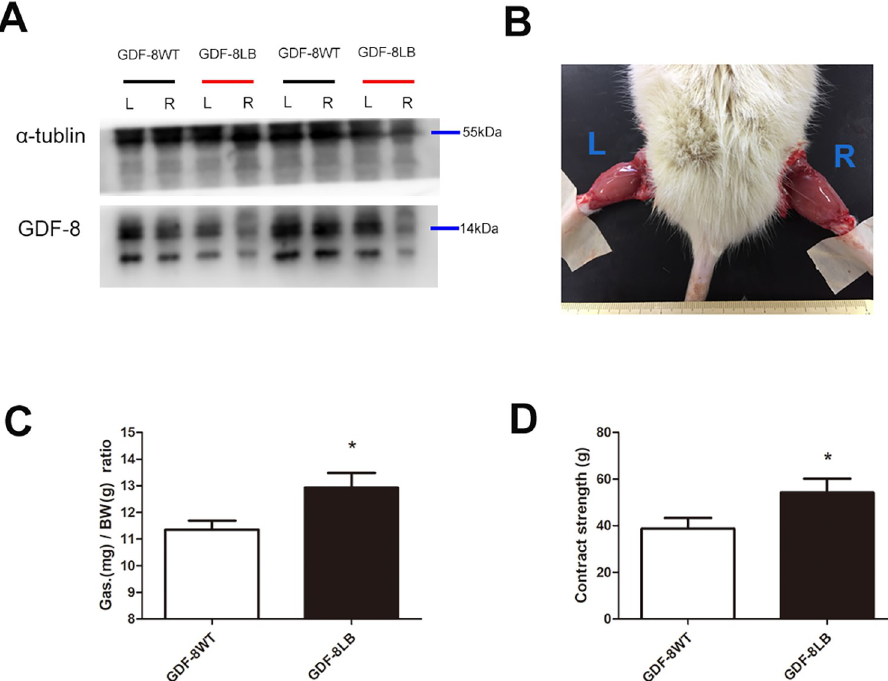
Fig 3. Local blockage of myostatin resulted in increased muscle mass and enhanced muscle strength in the right gastrocnemius muscles. A. expression level of myostatin (GDF-8) in the left and right gastrocnemius muscles in either GDF-8WT and GDF-8LB rats, after consecutive local injection of Ace-031 for 16 weeks; B, comparison of left and right gastrocnemius muscles of GDF-8LB rats after consecutive local injection of Ace-031 for 16 weeks; C. comparison of the gastrocnemius/body weight ratio; D. contraction force of right gastrocnemius muscle. ( � , P < 0.05; student t-test, n = 4).